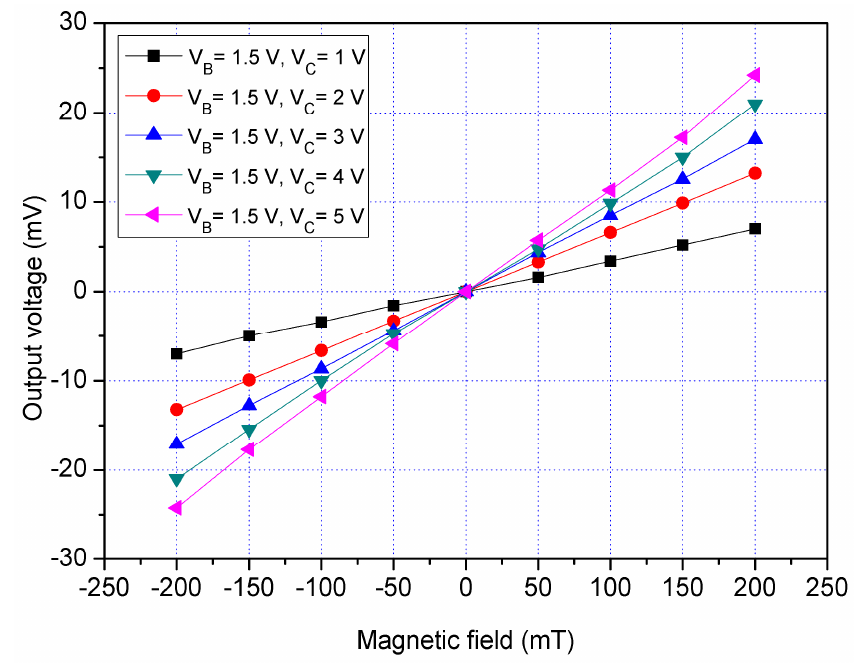
Figure 17. Measured Vo for the z-MSE at V B = 1.5 V in the z-direction MF.